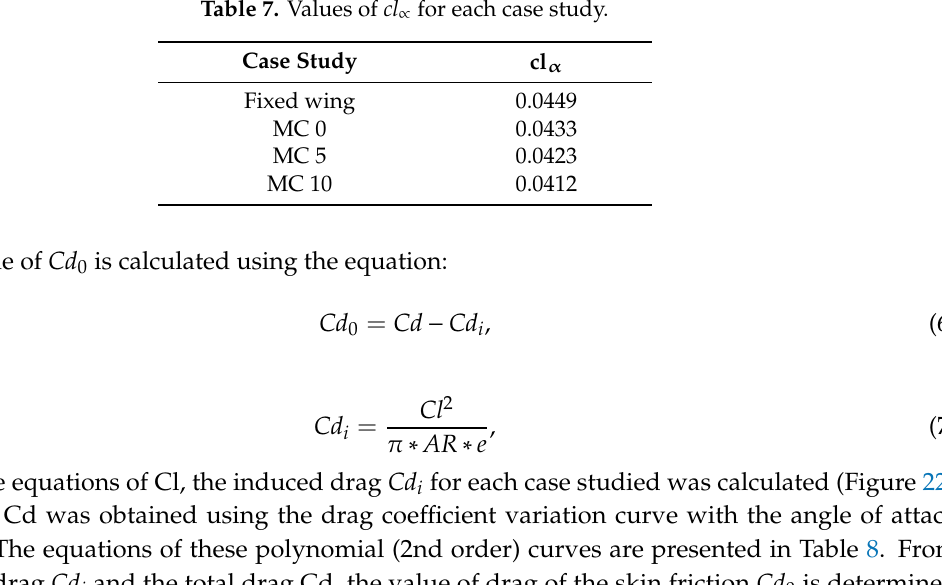
Figure 23. Drag coefficient Cd variation with the angle of attack. Table 8. Equation of drag coefficient variation with angle of attack. Studied cases